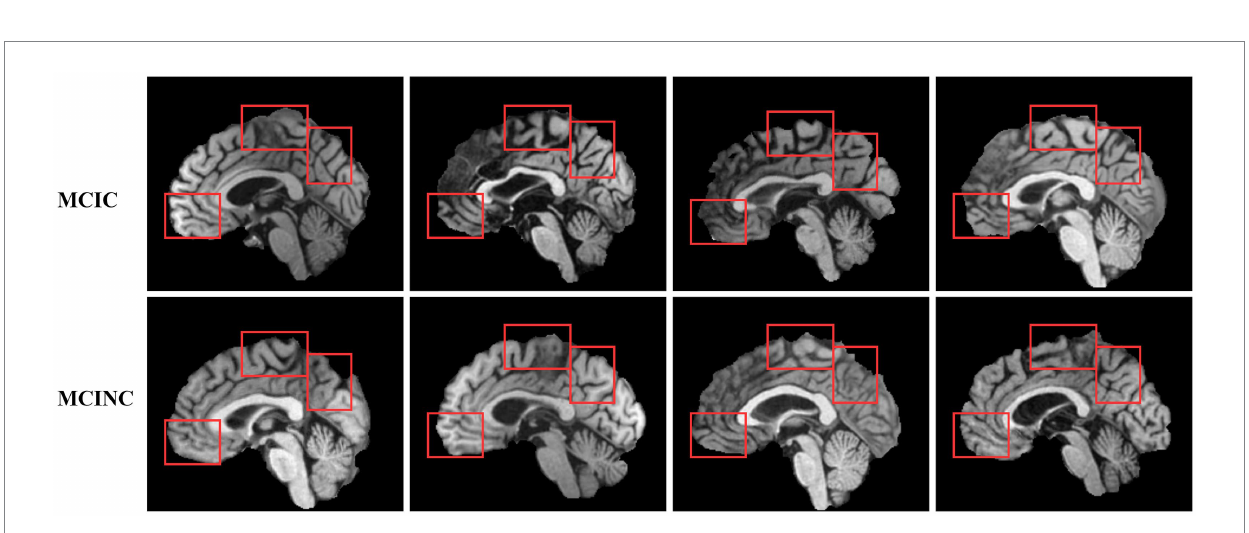
FIGURE 7 Example of MCIC and MCINC MRI scans with region of interest